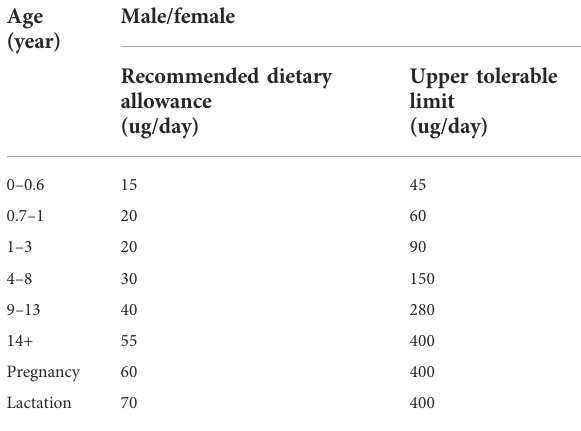
TABLE 1Selenium intake for children and adults(Institute of Medicine Food and Nutrition Board,